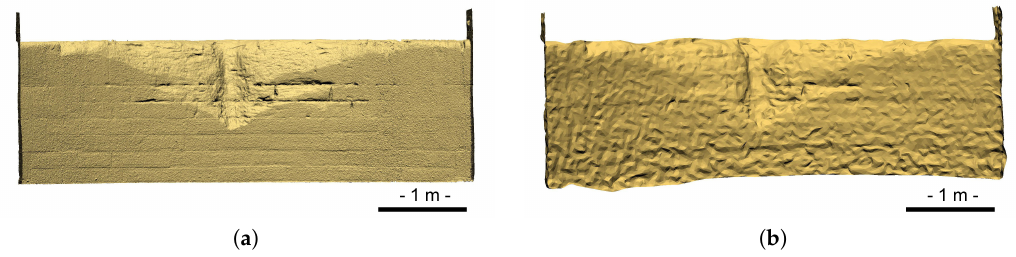
Figure 19. Front view of the ( a ) laser and ( b ) sonar models of the threshold wall. Both TLS and MSS scans were taken from the bottom of the